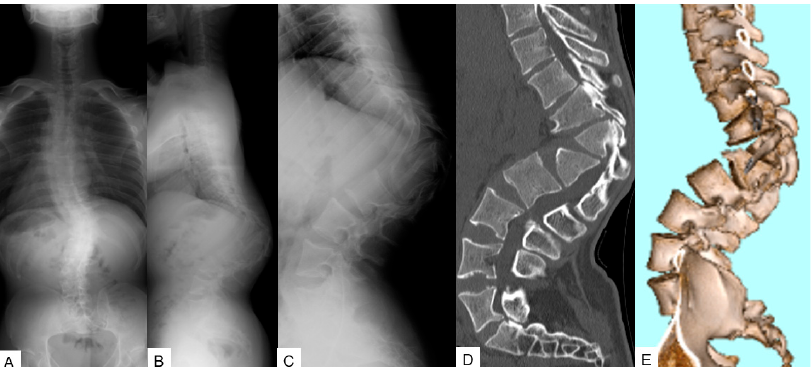
Figure 9. A 26-year-old man with achondroplasia; preoperative radiograms and CT. ( A ) Posteroan- terior radiogram; ( B , C ) lateral radiogram (T11-L2 local kyphosis 103°, SVA 60 mm, PT 27°, PI 81°); ( D ) sagittal reconstruction CT; ( E ) 3-D CT.